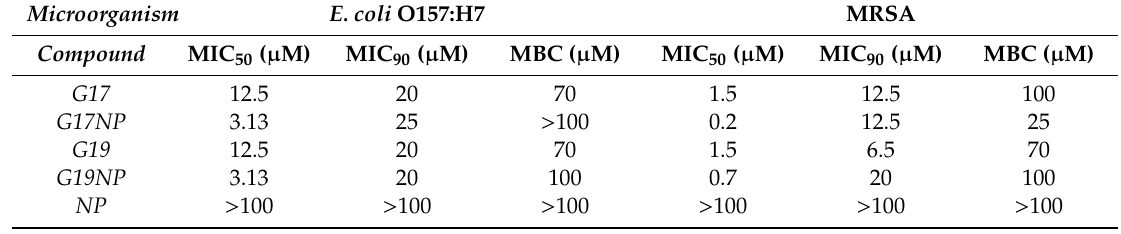
Table 3. Antimicrobial activity of free and encapsulated G17 and G19.